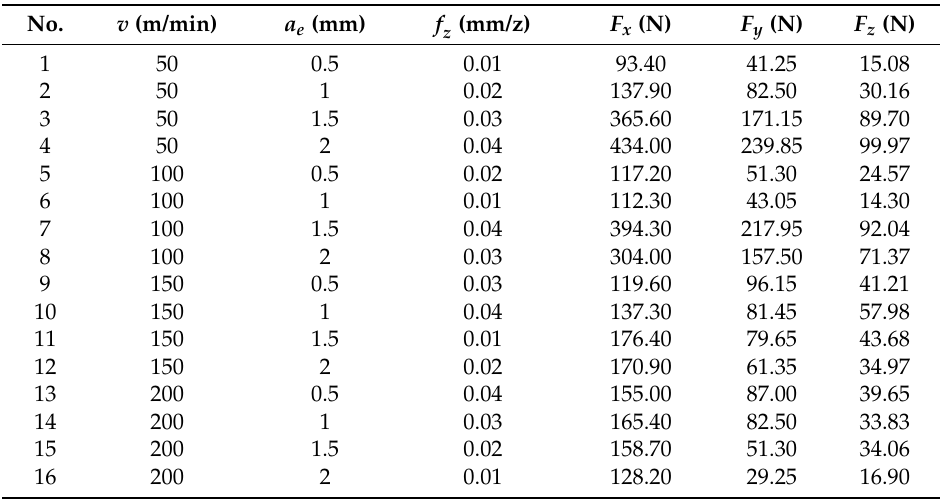
Table 5. Results of the milling